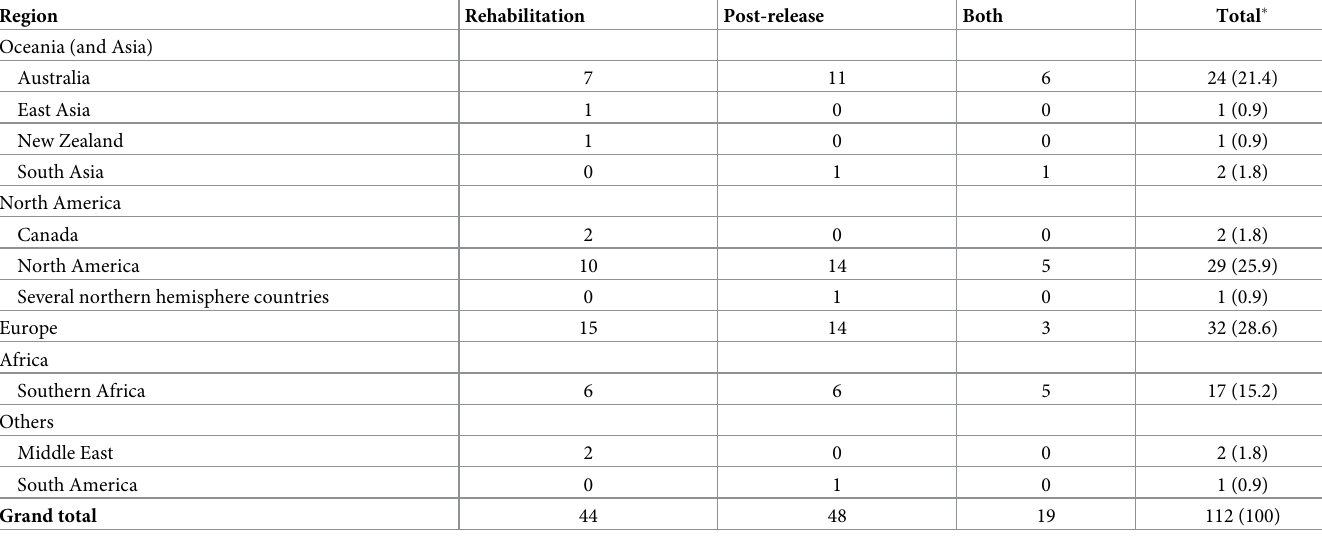
Table 1. Number of published articles from each country or region reporting survival of wildlife during rehabilitation, post-release or during both phases.